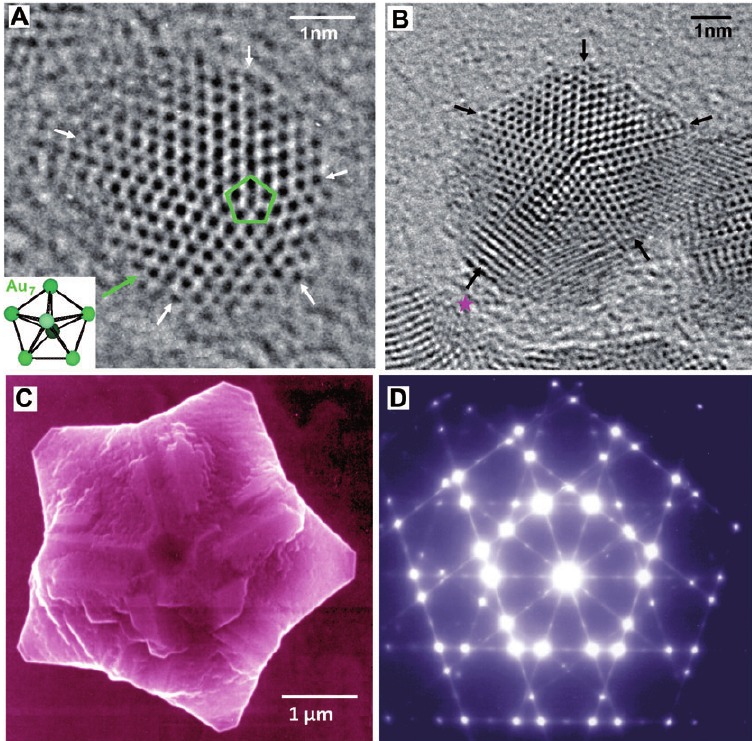
Figure 30 HREM images of gold nanoparticles (A) without and (B) with distortion. Twin planes are indicated by arrows. (C) SEM and (D) electron diffraction pattern of diamond